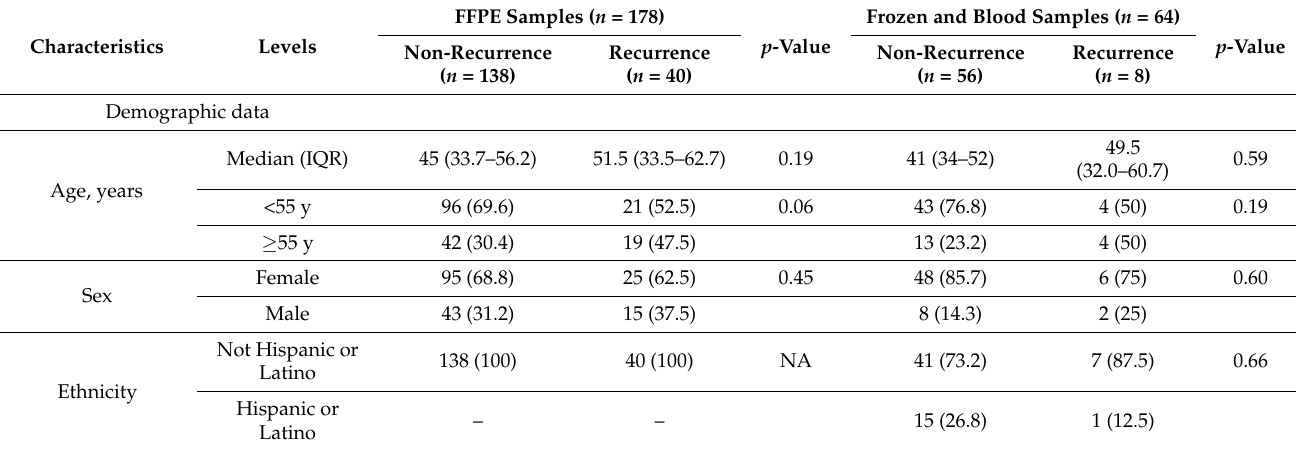
Table 3. Baseline characteristics of the study